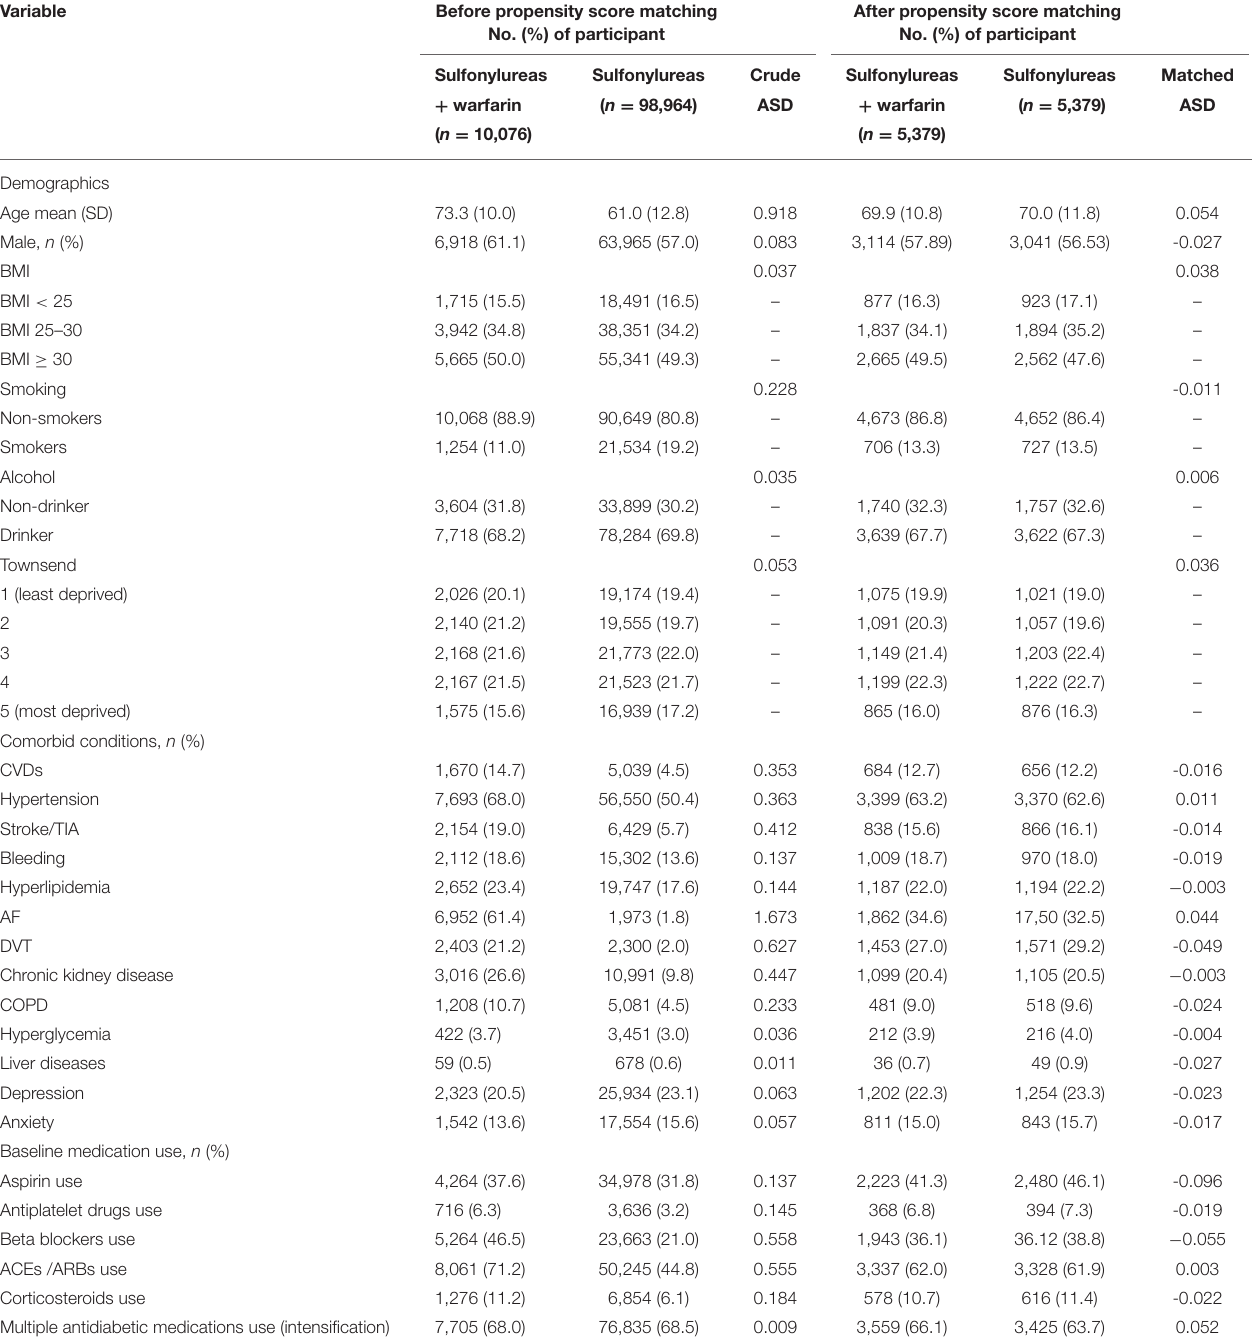
TABLE 1 | Individuals’ characteristics among the cohort of first analysis (sulfonylureas and warfarin vs. sulfonylureas only).